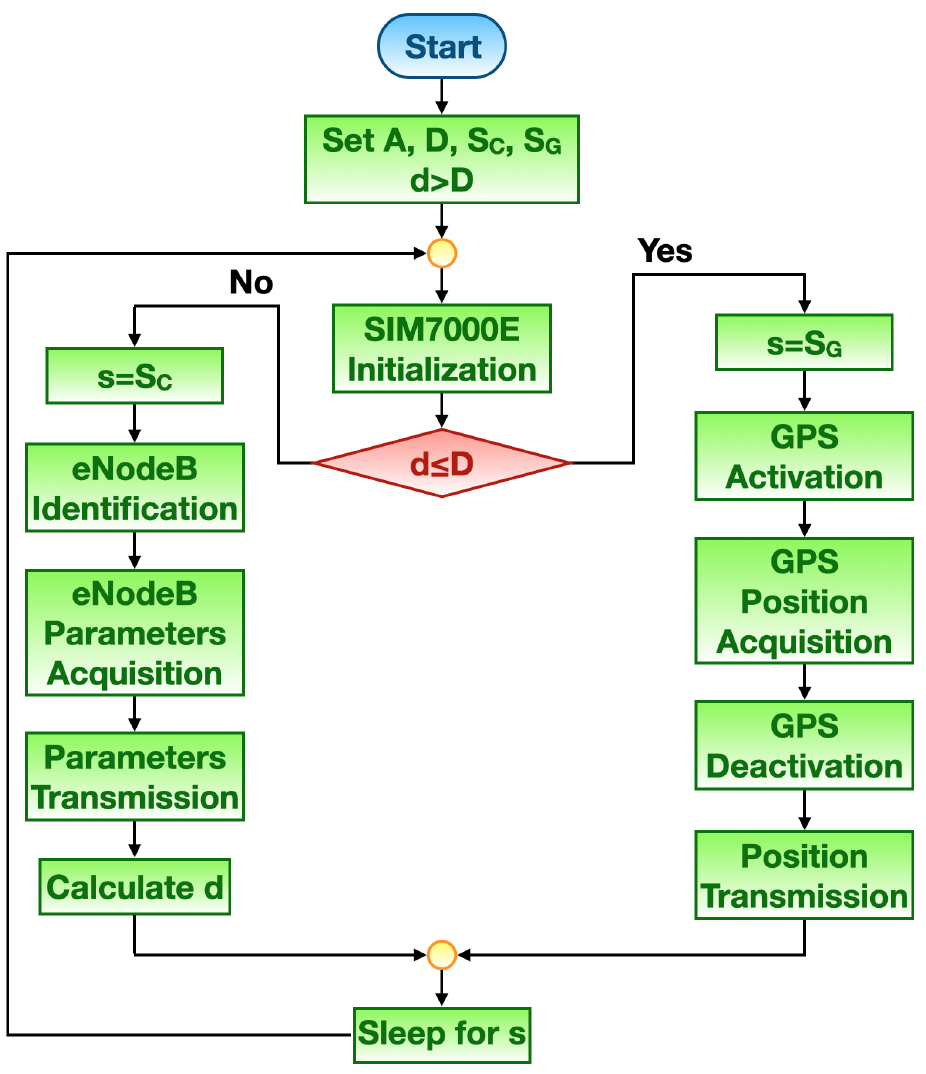
Figure 4. Mode #2 flow